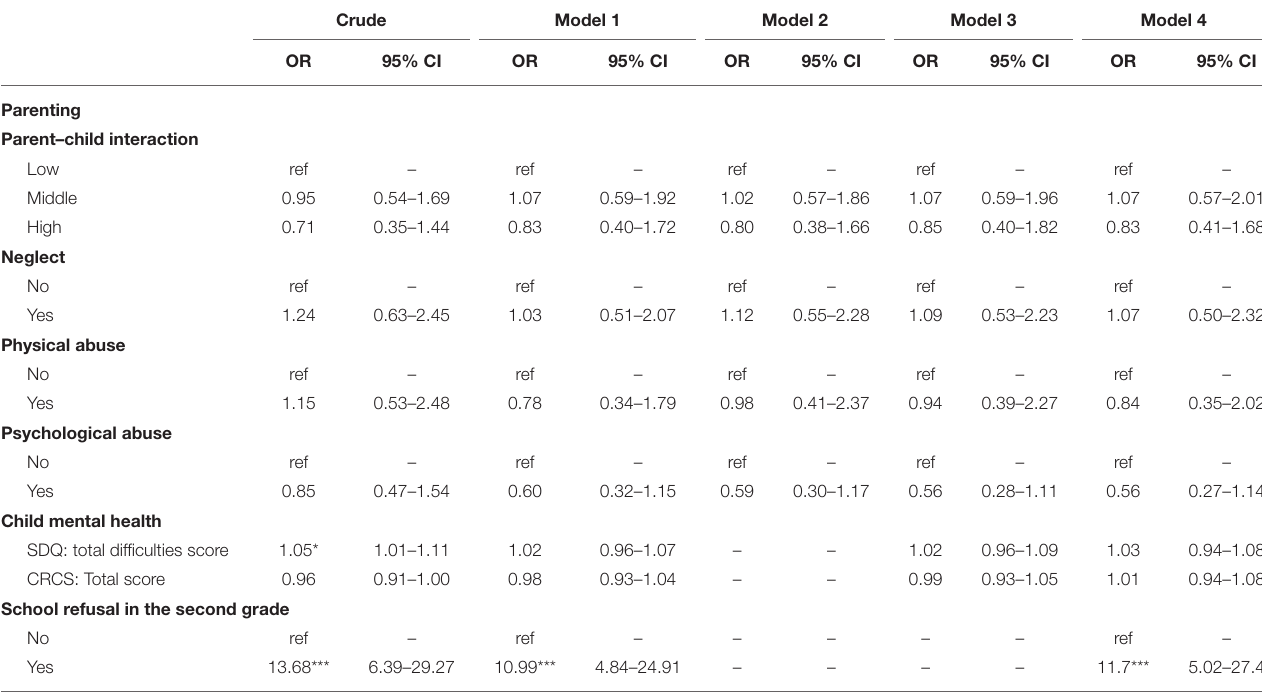
TABLE 4 | Association between parenting in the first grade and school refusal in the fourth grade after multiple